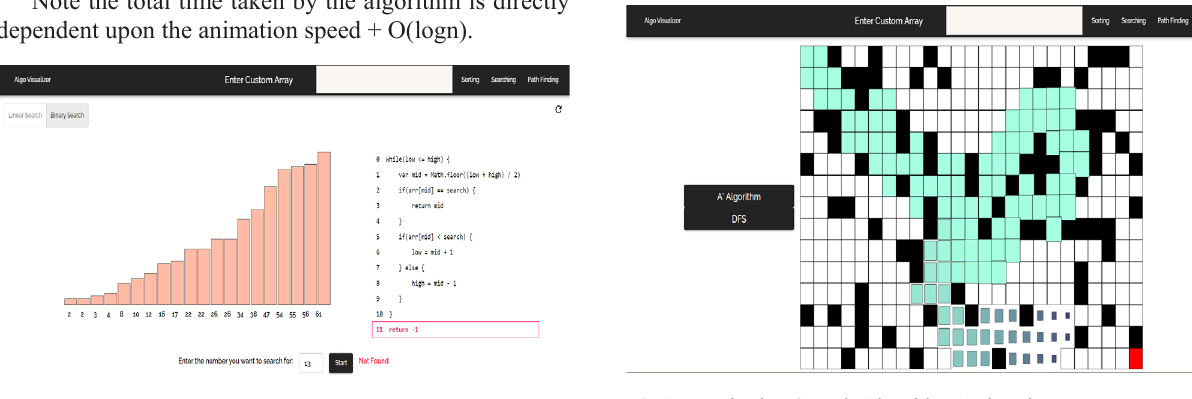
Fig.8. Depth First Search Algorithm